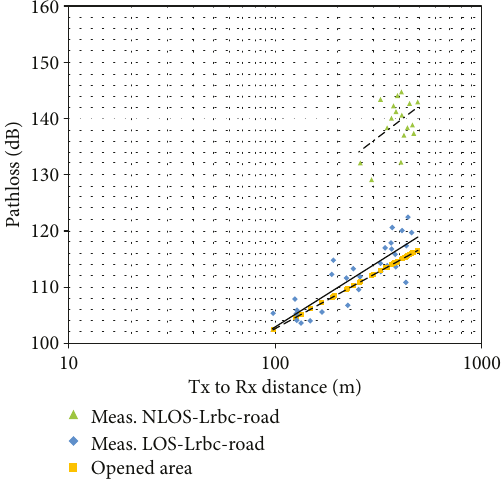
Figure 7: Pathloss characteristics according to the distance on the route that travels before the corner along the road (at site-speci fi